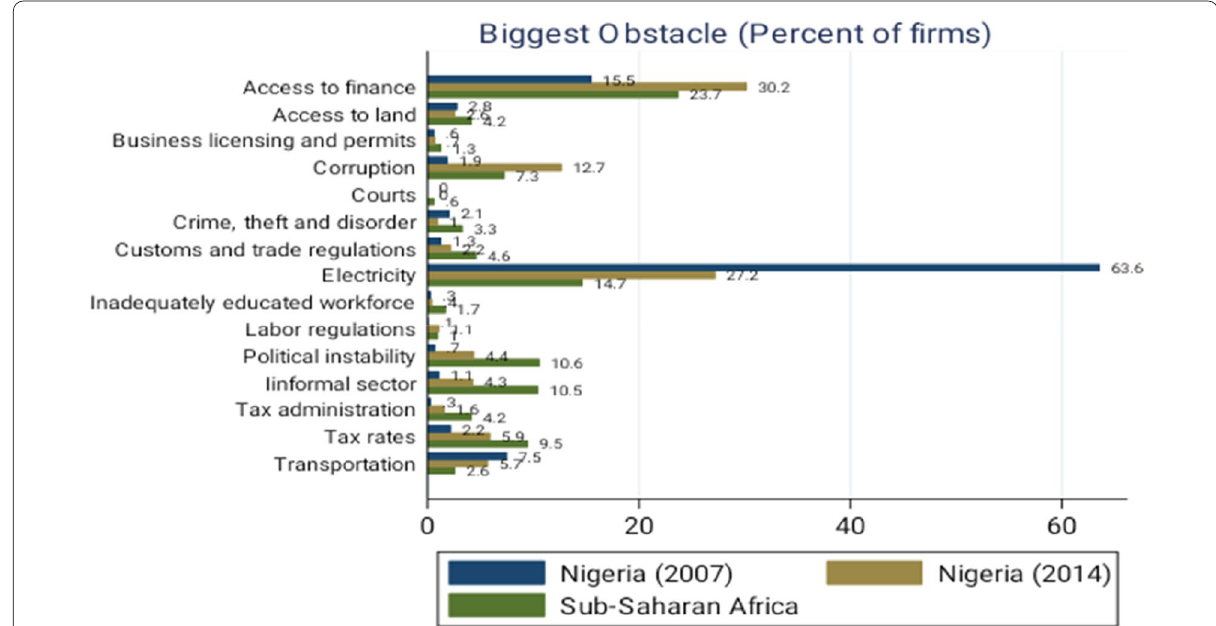
Fig. 2 Biggest obstacles to firms’ operation in Nigeria. Source: Author’s Computation using Enterprise Survey